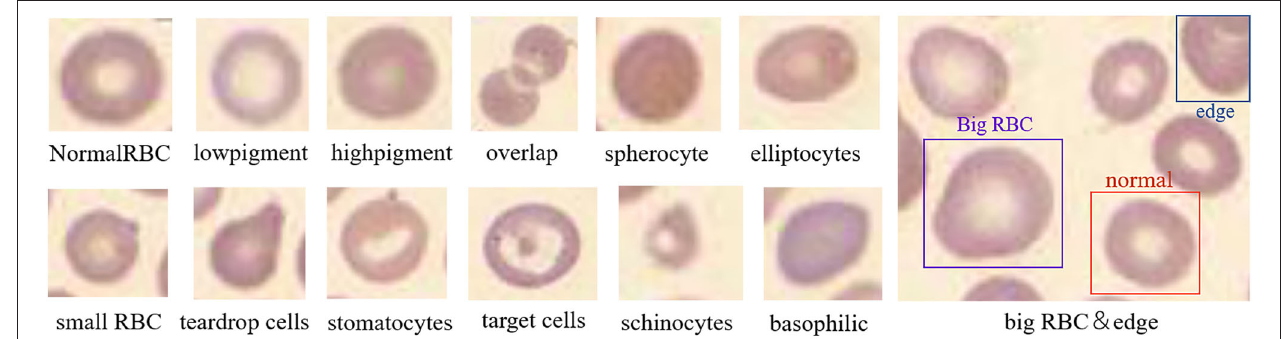
FIGURE 6 | Schematic diagram of normal and abnormal red blood cells. This picture illustrates the most obvious characteristics of each red blood cell, such as the shape, size, and hemoglobin content.